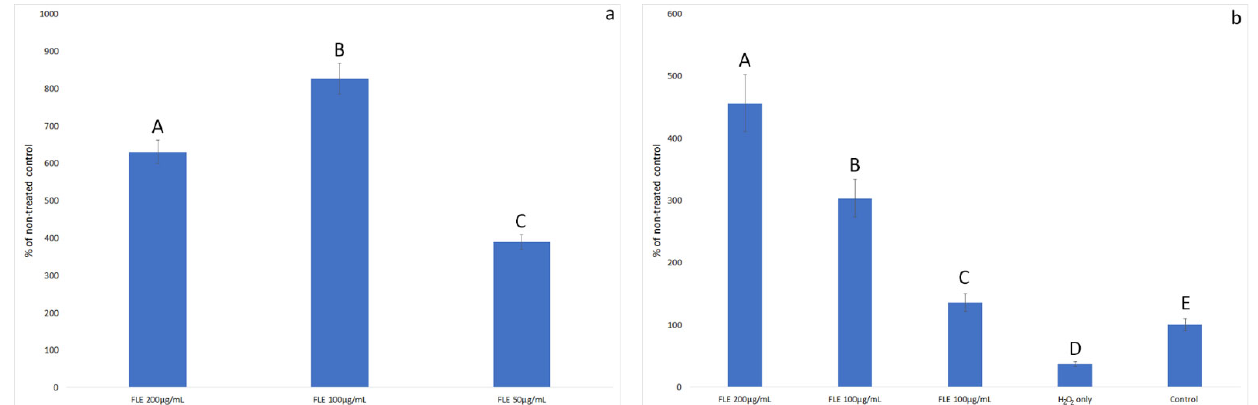
Figure 4. The proliferation of HFFF ‐ 2 cells treated with (a) Faxonius limosus extract and (b) treated with Faxonius limosus extract or PBS (only H 2 O 2 ) and 500 μ M hydrogen peroxide. Results are shown as percentage of control viability to which only PBS was added (no extract and no H 2 O 2 ). Different letters mean that the values for the bars differ statistically ( p < 0.05).